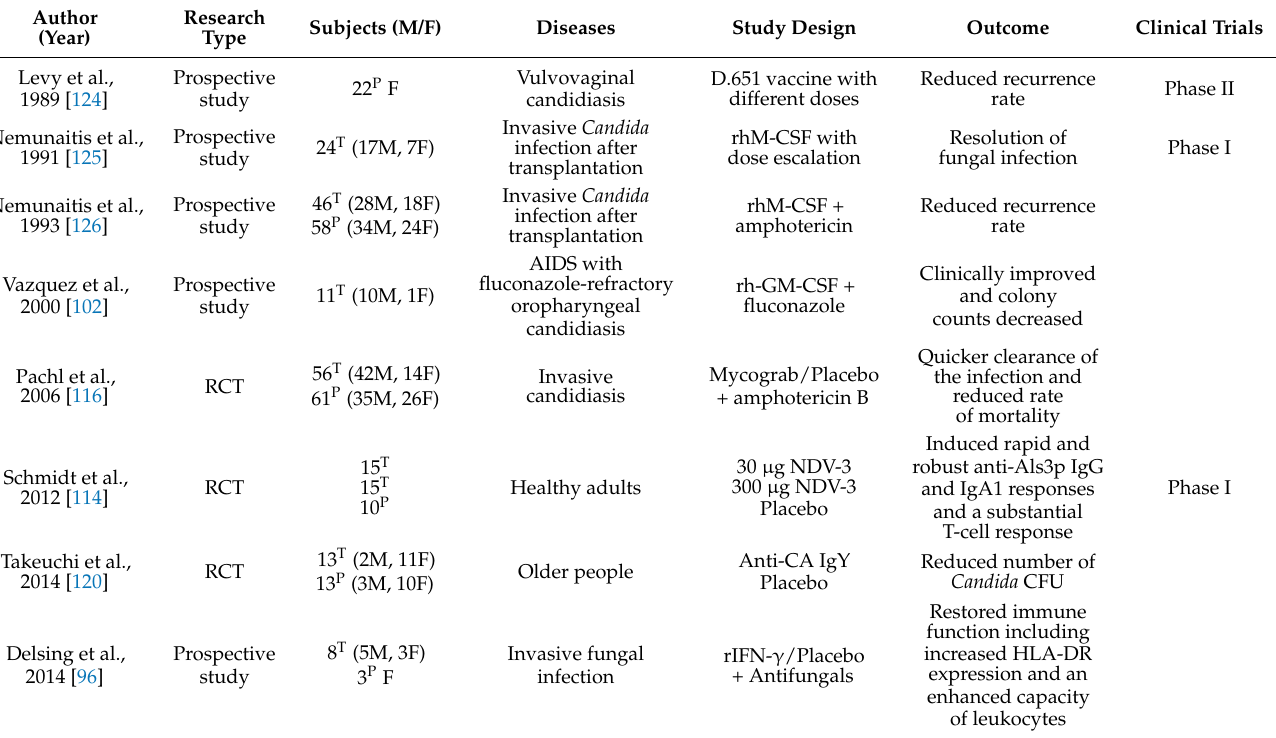
Table 1. Eleven clinical trials of host-directed